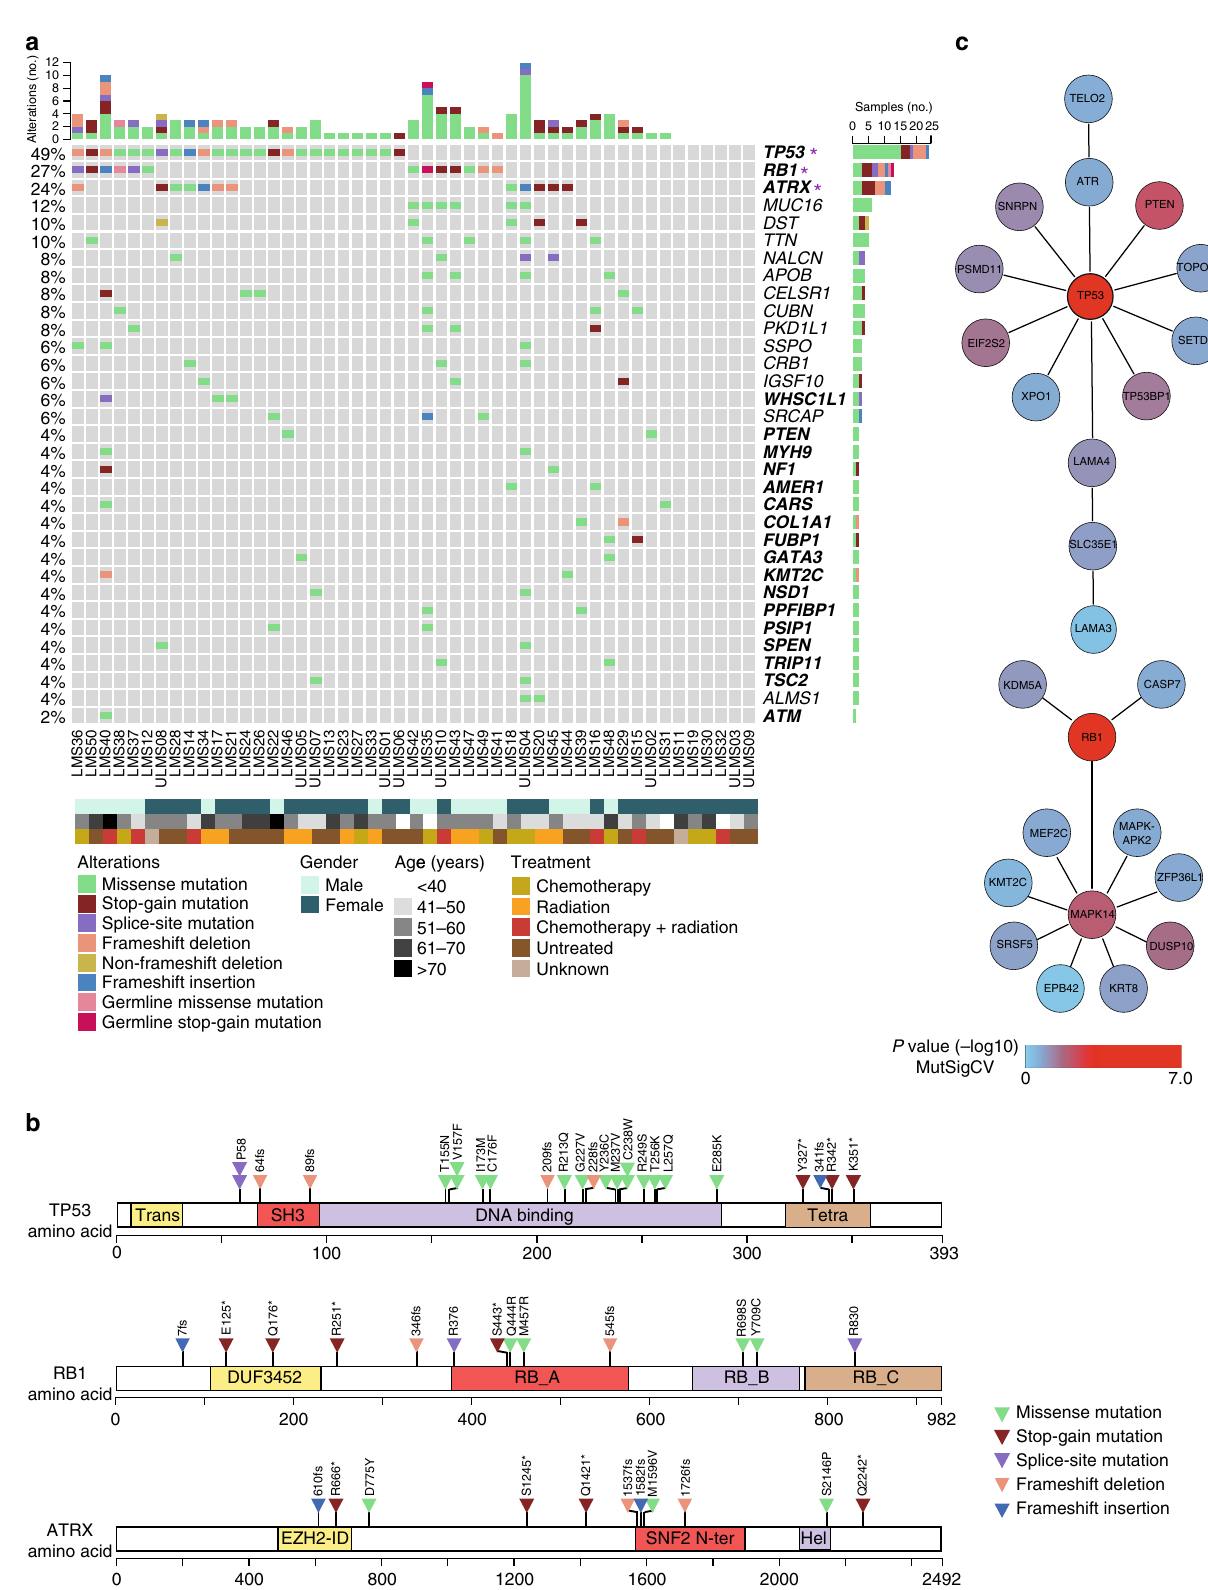
DNA binding Tetra